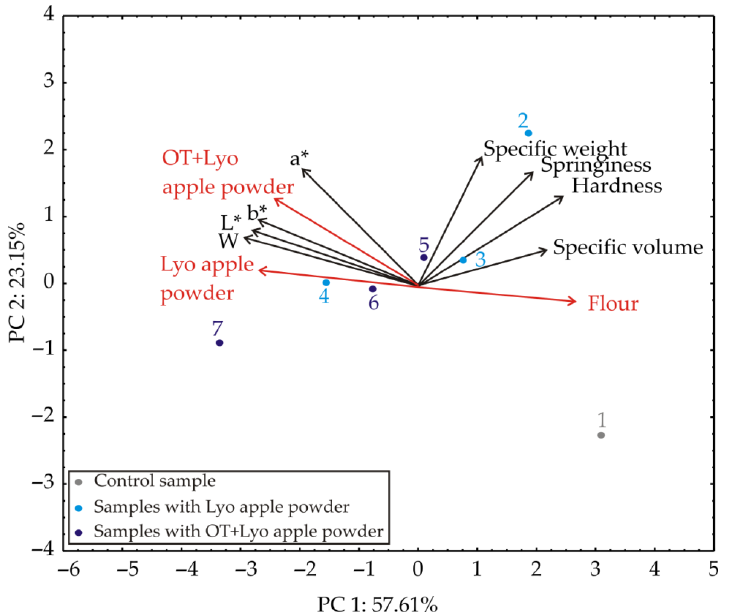
Figure 4. PCA biplot diagram depicting the relationships among muffin samples regarding color and technological characteristics.